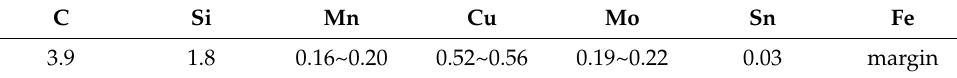
Table 1. The main chemical composition of compacted graphite cast iron (CGI). W B /%.